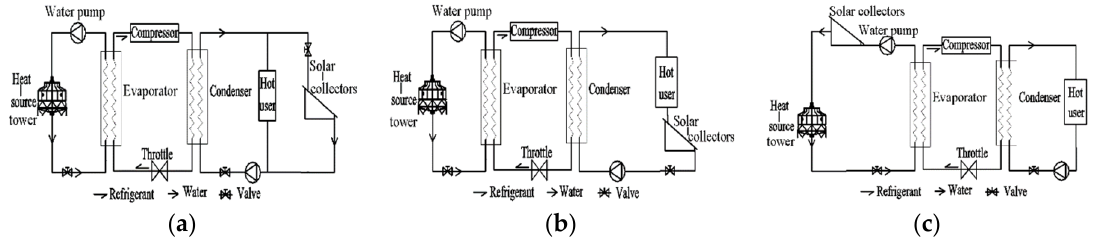
Figure 1. Schematic diagram of three heating systems: ( a ) SC//HP, ( b ) SC+HP, ( c ) HST+SC.